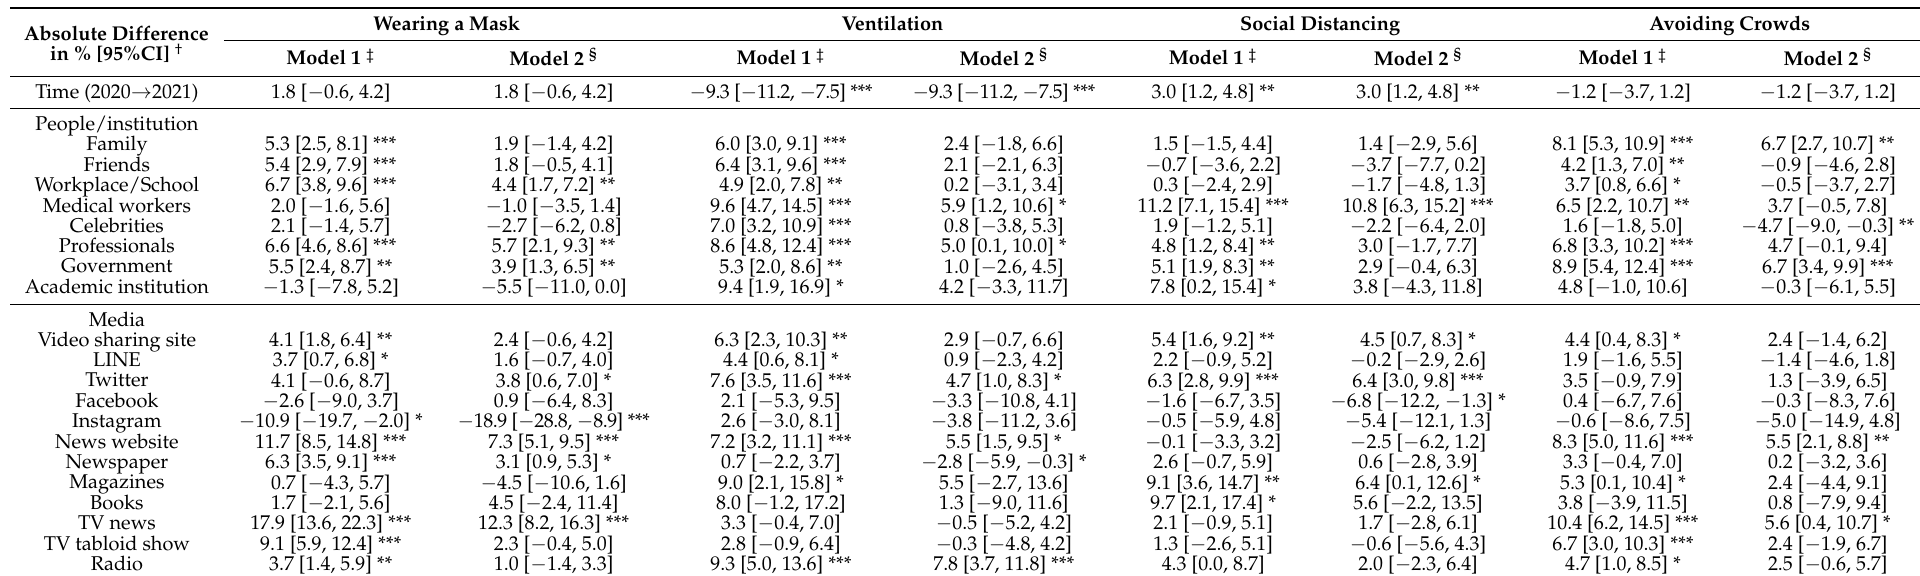
Table 3. The association between each information source and preventive behavior for COVID-19 ( n =